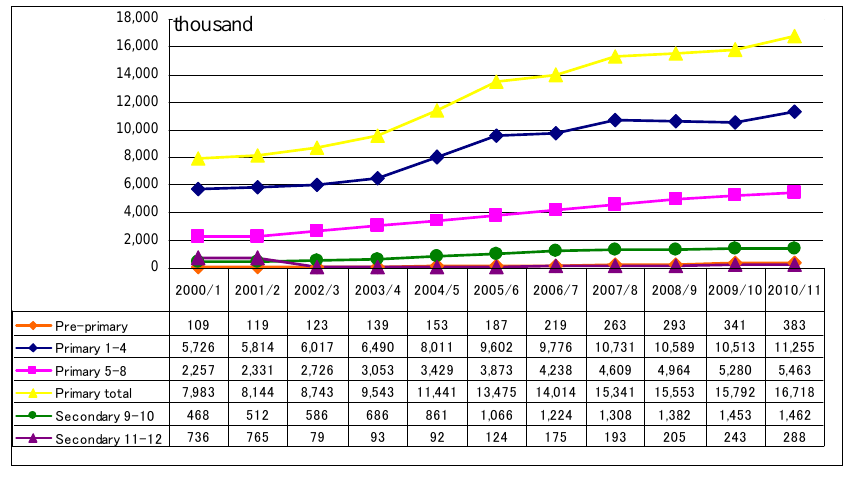
Figure 4-1: Enrollment in General Education (Grades 1-12) (2000/01 - 2010/11) Comparing the enrollments in the government and non-government schools, while more than 90% of students go to the government primary schools in most regions, in Addis Ababa 58% of students go to the non-government primary schools (MOE, 2011a) (See Annex 4-2).